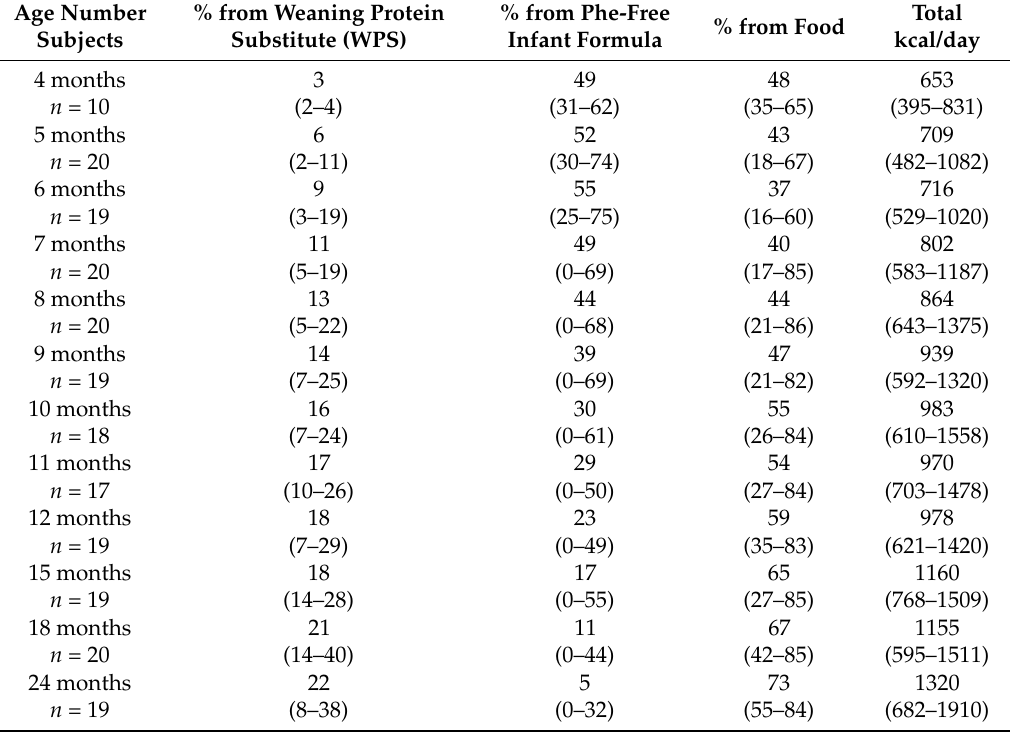
Table 1. Total energy intake (kcal/day) and percentage of total energy intake attributed to protein substitutes (infant and weaning) and food (mean (range)).